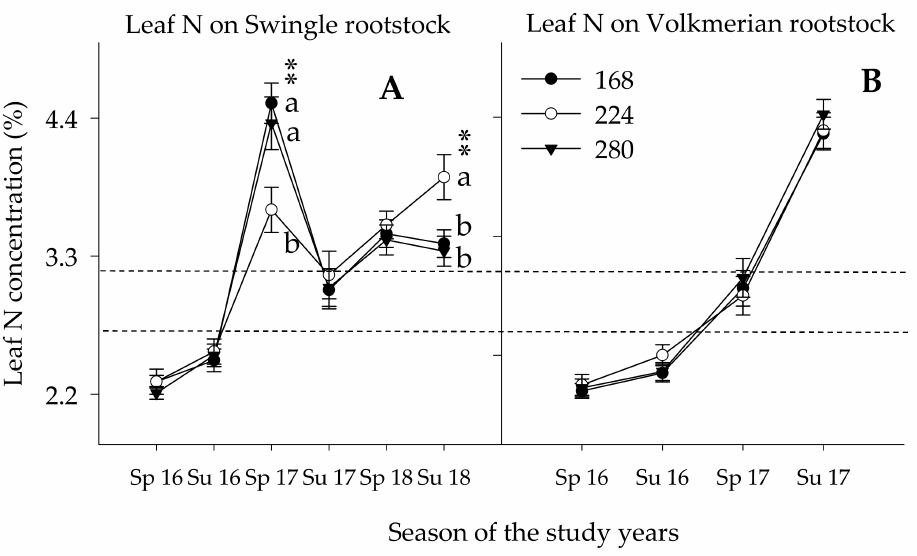
Figure 5. Leaf N concentration in spring (sp, Feb. /Mar) and summer (su, Aug. /Sept.) seasons of 2016–2018 growing seasons of Valencia citrus trees budded on Swingle ( A ) and Volkameriana ( B ) rootstocks at three N rates (168, 224, and 280 kg ha − 1 ). No data for trees on Volk for 2018 as Hurricane Irma removed the trees in summer 2017. Asterisks (**) indicate significance at p ≤ 0.01. The space between the two broken lines indicates the optimum range of leaf nutrient concentrations. Means along the same vertical alignment with the same lower case letters are not significantly different ( p ≤ 0.05) using the Tukey’s range